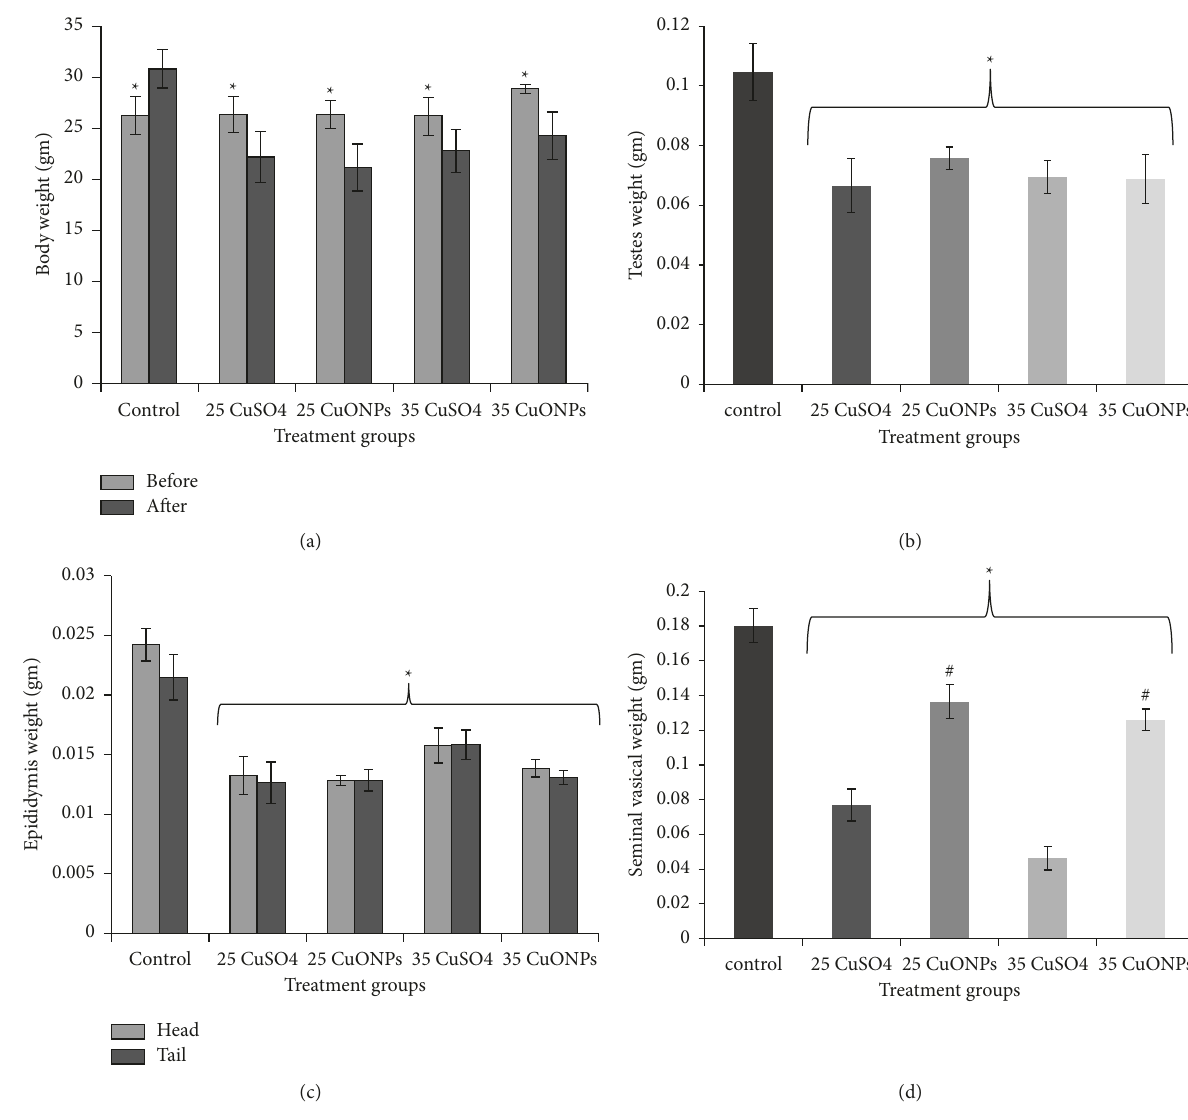
Figure 5: Effect of CuO NPs and CuSO 4 0.5 (H 2 O) on rat at different concentrations (25 and 35mg/kg) after 14 days of exposure on (a) body weight, (b) testes weight, (c) epididymis weight, and (d) seminal vesical weight. Table 1: Changes in male mice body weight and reproductive organs induced by treatment with copper nanoparticles and copper sulphate. Treatment Body weight before Body weight after Testes index Epididymis index Epididymis index Seminal vesicle groups treatment (gm) treatment (gm) (%) (head) (%) (tail) (%) index (%) Control 26.25 ± 1.85 30.82 ± 1.88